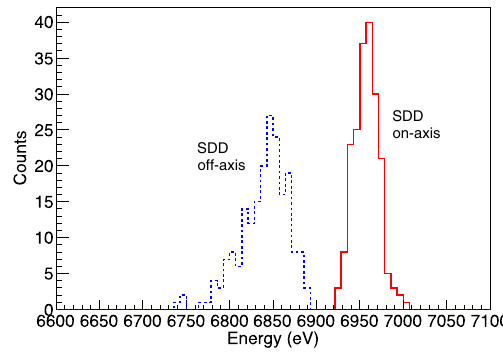
FIG. 30. Calculated energy spectra of the LCS photons at the detector. The solid line shows a spectrum with a perfectly aligned detector and the dotted line is for a detector having position error of 1.5 mm in the horizontal and vertical